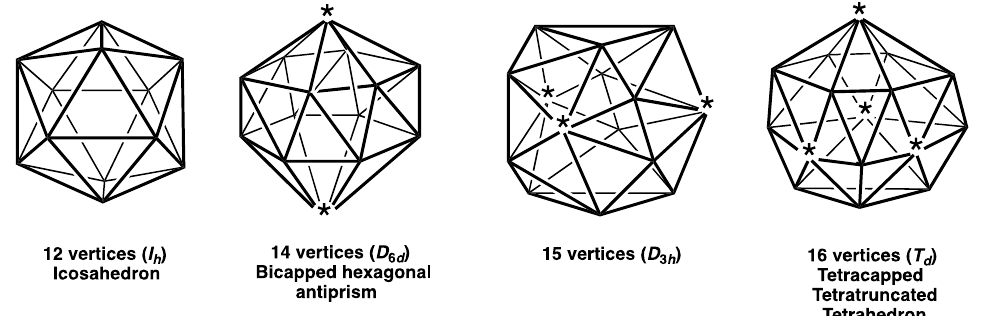
Figure 2. The four Frank ‐ Kasper deltahedra with the degree 6 vertices starred.